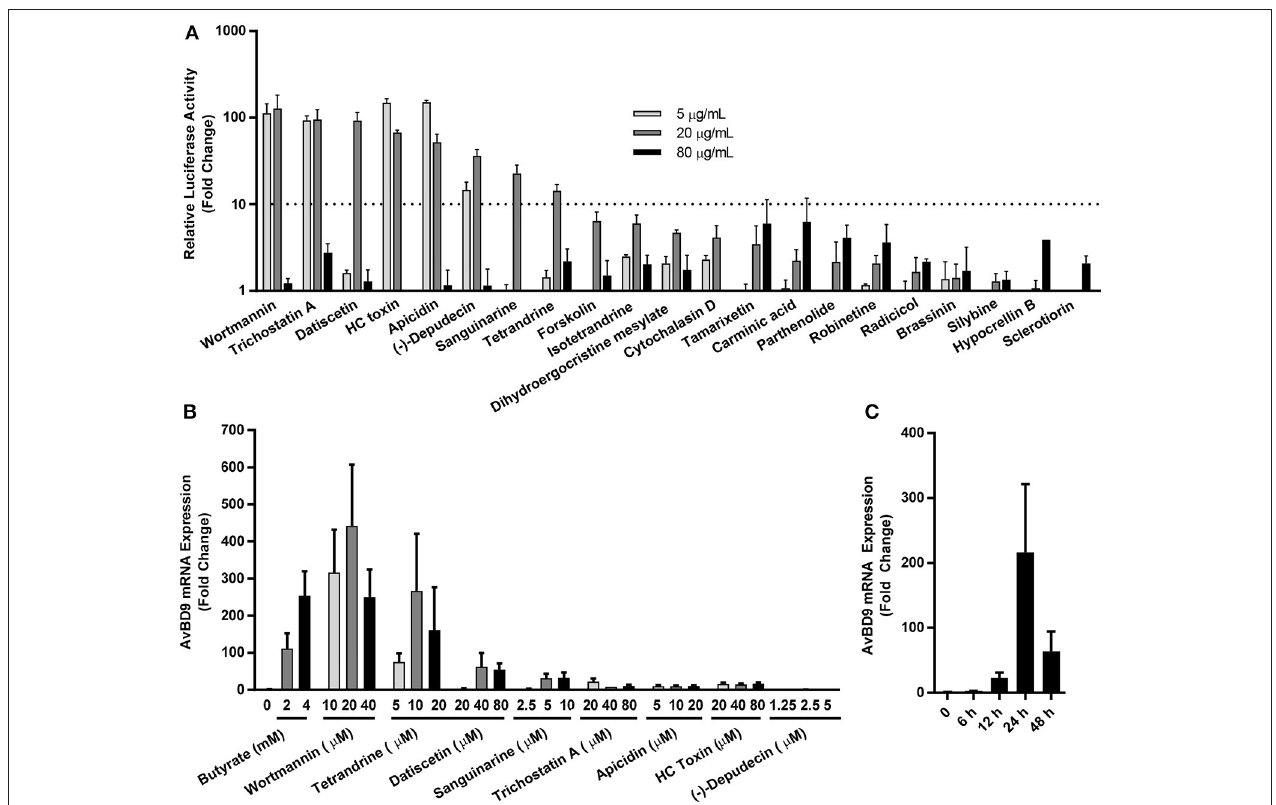
FIGURE 4 | Secondary screening of newly identified natural HDP-inducing compounds. (A) Dose-dependent changes in luciferase activity in stable HTC/ AvBD9 - luc luciferase reporter cells in response to 21 hits identified in the primary screening. (B) Dose-dependent induction of AvBD9 mRNA expression in parental HTC cells stimulated with selected compounds for 24h by RT-qPCR. (C) Time-dependent changes in AvBD9 mRNA expression levels in HTC cells treated with 10 µ M wortmannin by RT-qPCR. The results are means ± SEM of three independent